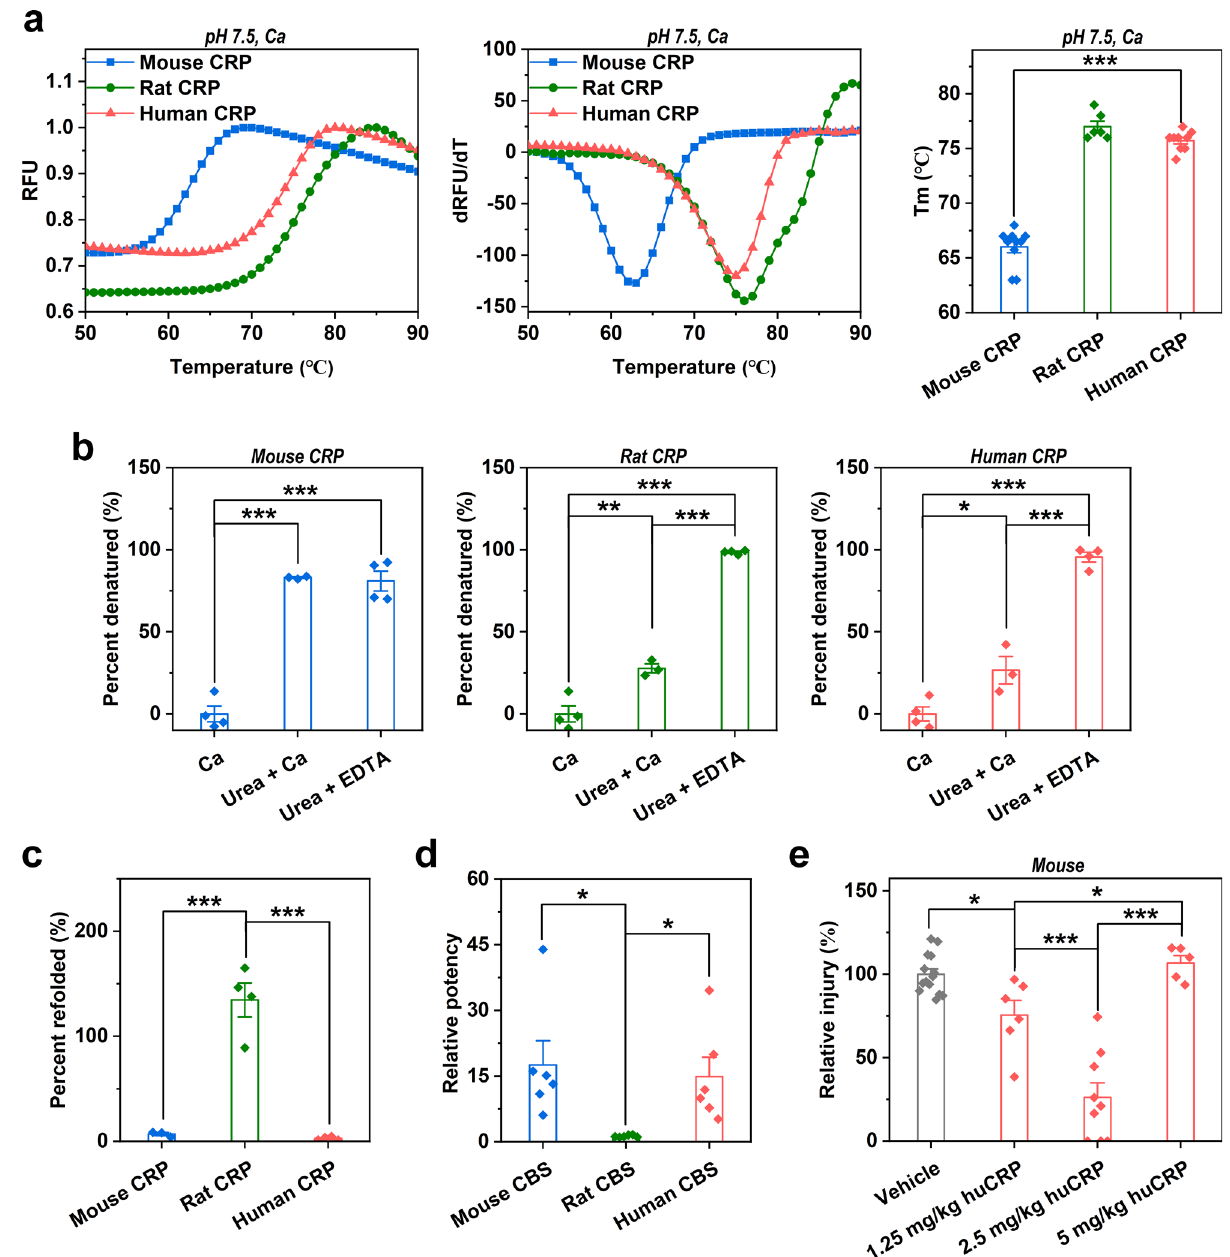
Fig. 3 The unfolded structure and associated hidden activities of CRP are evolutionarily distinct. The stability of mouse, rat, and human CRP was examined with heat- ( a ) ( n = 10 independent experiments for mouse CRP; n = 6 independent experiments for rat CRP; n = 9 independent experiments for human CRP) and urea-induced unfolding ( b ) ( n = 4 independent experiments). The melting temperature (Tm) of mouse CRP was much lower than that of rat and human CRP. Accordingly, calcium exhibited little effect on urea-induced unfolding of mouse CRP, but markedly inhibited that of rat and human CRP. c The refolding of urea-unfolded CRP was examined following dilution ( n = 3 independent experiments for mouse CRP; n = 4 independent experiments for rat and human CRP). Rat CRP ef fi ciently refolded, whereas mouse and human CRP did not. d The hidden activities of the major functional motif of unfolded CRP, i.e., CBS, were examined with competitive ELISA against 6 ligands 36 . Relative potency for each ligand was de fi ned as: binding of mCRP in the absence of CBS divided by that in the presence of CBS. Each data point represents a potency index of a different ligand ( n = 3 independent experiments). Mouse CBS was most active, while rat CBS was least active. These results indicate that mouse CRP is most prone to unfold and possesses the strongest hidden activities. By contrast, rat CRP is most resistant to unfolding and possesses the weakest hidden activities. e Wild-type mice with acetaminophen-induced liver failure were treated with human CRP at the indicated dosages ( n = 14 mice for vehicle; n = 6 mice for 1.25 mg/kg dosage; n = 9 mice for 2.5 mg/kg dosage; n = 5 mice for 5 mg/kg dosage). Human CRP reduced liver injury at dosages of 1.25 and 2.5 mg/kg, but showed little effect at the dosage of 5 mg/kg. The loss of protection of human CRP at the highest dosage might be due to strong proin fl ammatory responses evoked by excessive mCRP. Data are presented as mean ± SEM; * p < 0.05; ** p < 0.01; *** p < 0.001, one-way ANOVA with Tukey post